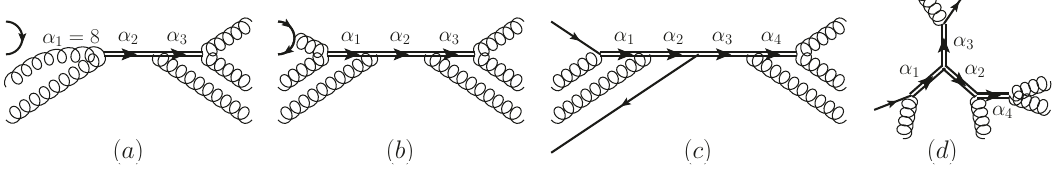
Figure 1 . Basis vectors with quark-antiquark pairs combined into a singlet, (a), an octet, (b), and a basis vector where they are not combined, (c). The basis vectors in (a), (b) and (c) are divided into an incoming side, with half of the partons (rounded up) and an outgoing side, with the other half (rounded down), swapping a quark (antiquark) from the incoming to the outgoing side (or vice versa) only changes its label to an antiquark (quark). Figure (d) displays a basis vector that would require vertices between three general representations, (cid:11) 1 , (cid:11) 2 and (cid:11) 3 . Double-lines carry the representation given by their